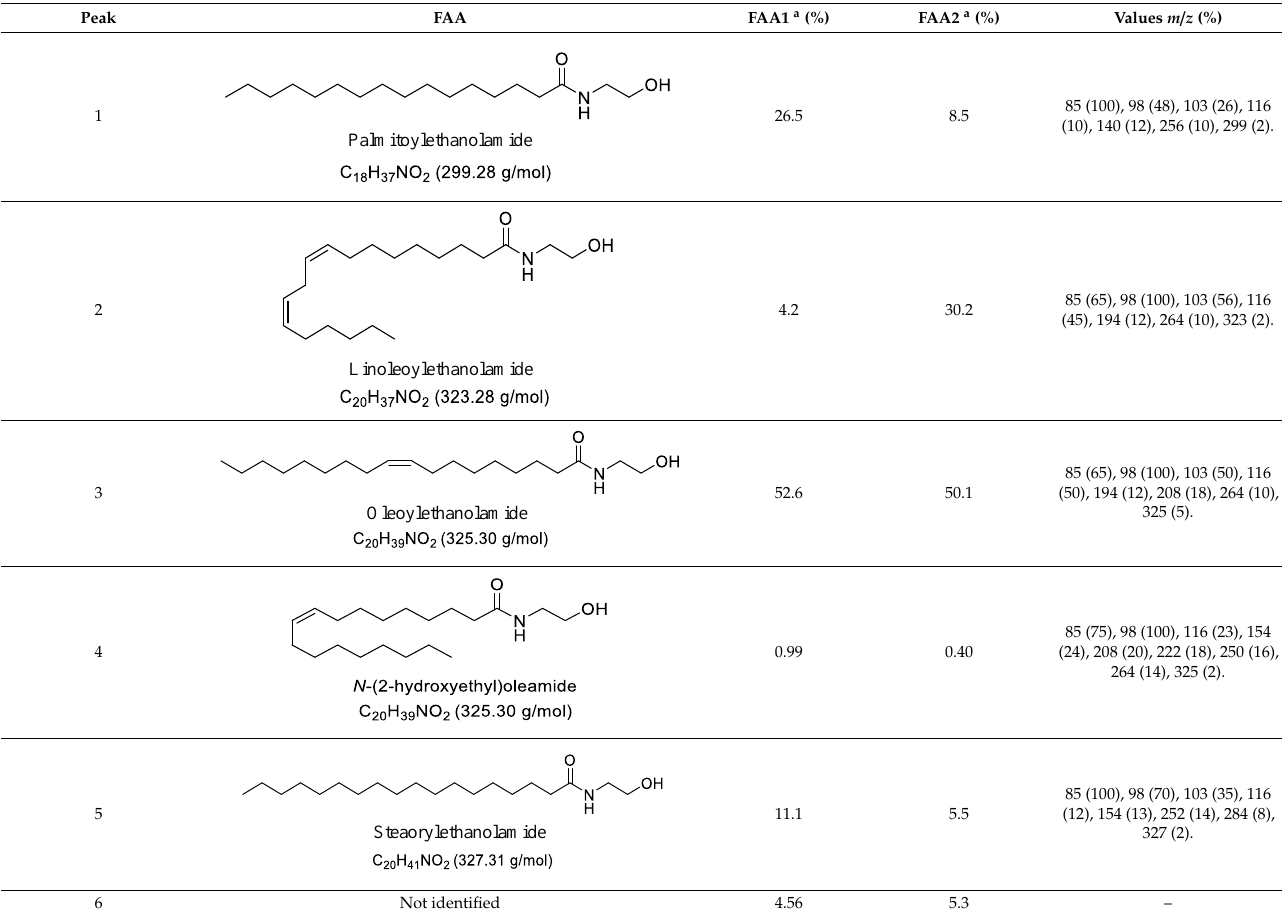
Table 1. Composition of fatty acid amides (FAA) from andiroba oils (AO) by gas chromatography-mass spectrometry (GC-MS) catalyzed by lipases from Candida antarctica -B (CAL-B).